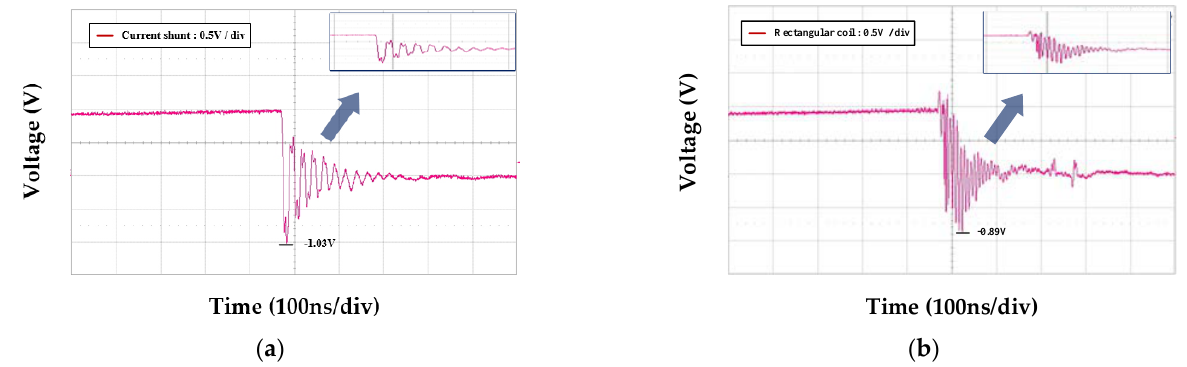
Figure 16. Integrator output waveforms during switch turn-off of pickup coils and shunt resistor sensor at DC link voltage V dc of 250 V: ( a ) switch-on condition and ( b ) switch-off condition.